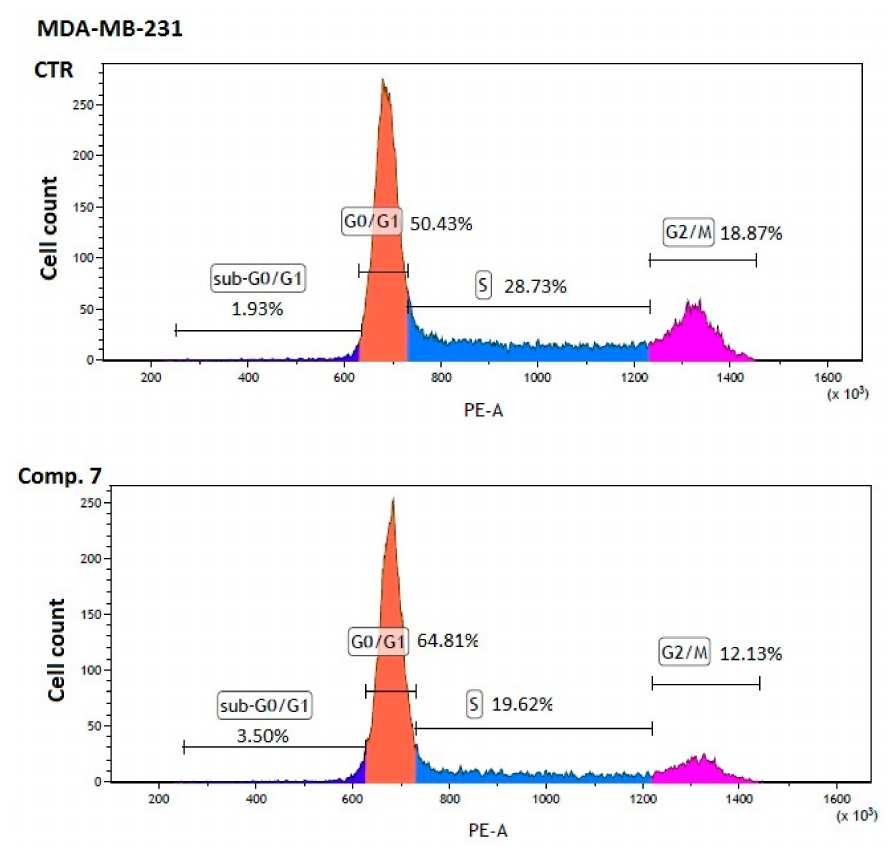
Figure 8. E ff ects of selected sulfonamides on MCF-7 and MDA-MB-231 cell cycle progression. MCF-7 cells were treated with compounds 1 , 4 and 7 at concentrations corresponding to their IC 50 values for 24h. MDA-MB-231 were treated with compound 7 at a concentration corresponding to the IC 50 value. DNA content was determined using a flow cytometry analysis of PI-stained cells. Representative cytograms of the cell cycle distribution at G0 / 1, S and G2 / M phases are